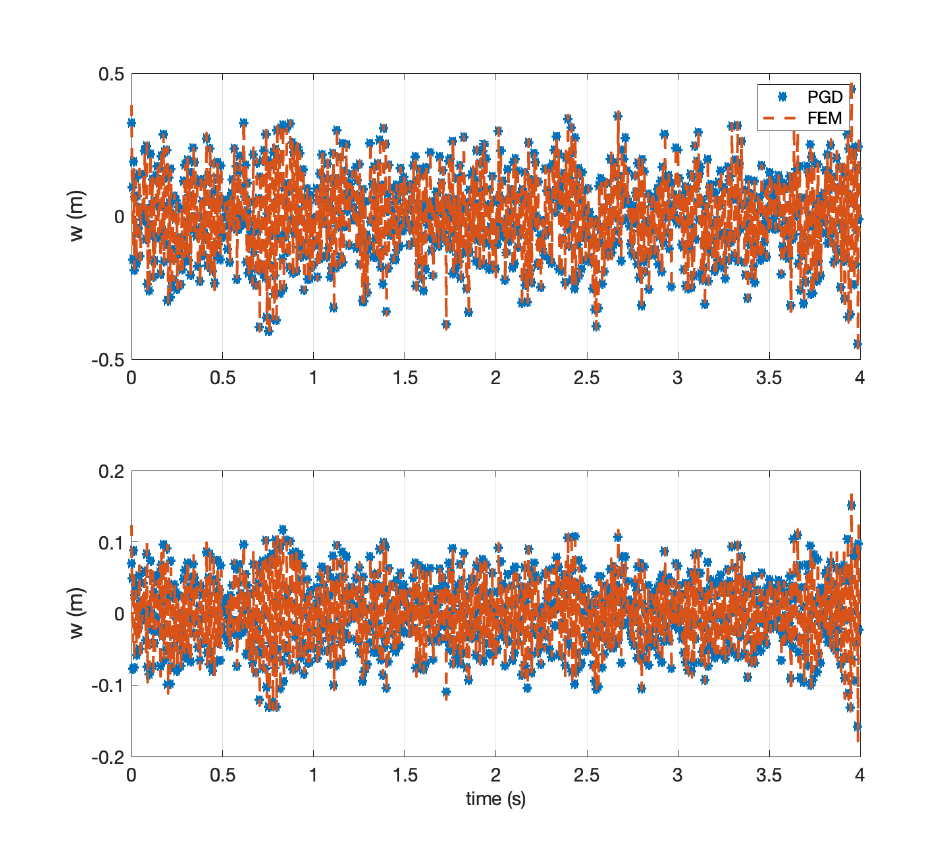
Figure 10. z-component of the displacement at the top of both layers: (top) top layer and (bottom) bottom layer.